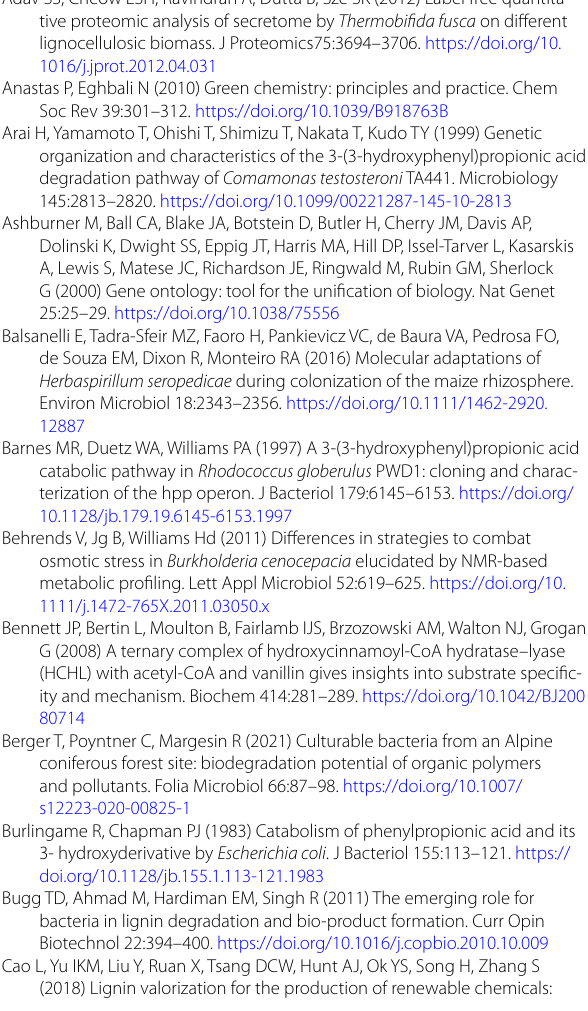
Additional file 1: Figure S1. PCA analysis. The RNA-sequencing results of the 3 biological replicates cultivated with glucose (G1-3) or ferulic acid (FA1-3) are depicted. Table S1. OD600 and HPLC values. Table S2. Sequencing statistics. Table S3. Gene expression values. Table S4.